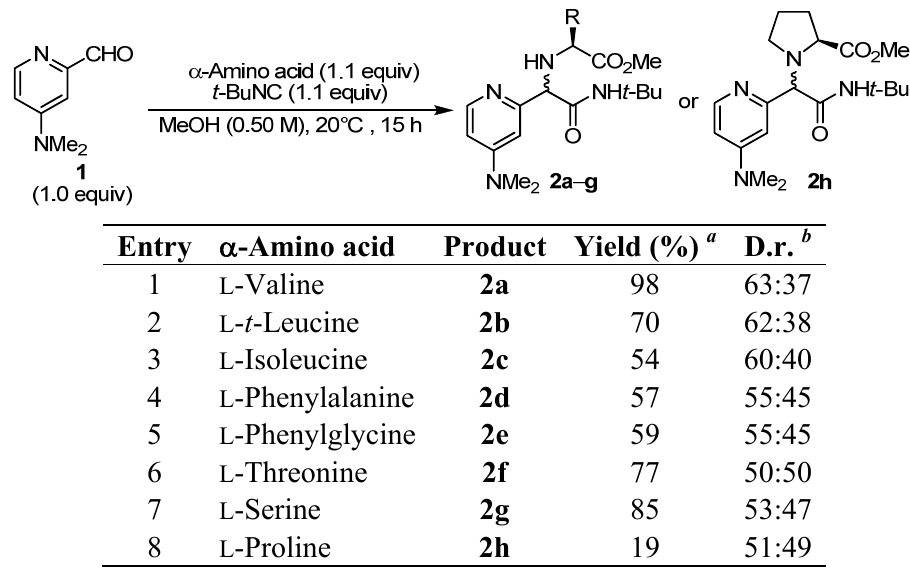
Table 2. Ugi reaction of 1 with various  -amino